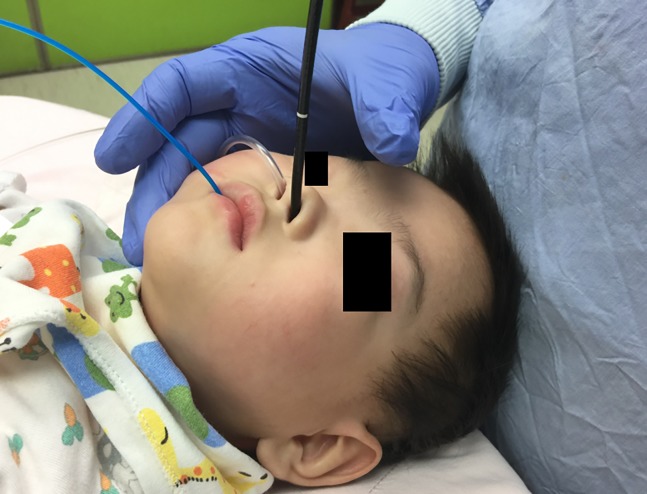
Picture of an infant undergoing therapeutic flexible bronchoscopy supported with this noninvasive ventilation maneuver.A nasopharyngeal oxygen catheter inserted into right nostril, a balloon catheter via mouth and a flexible endoscope via left nostril.